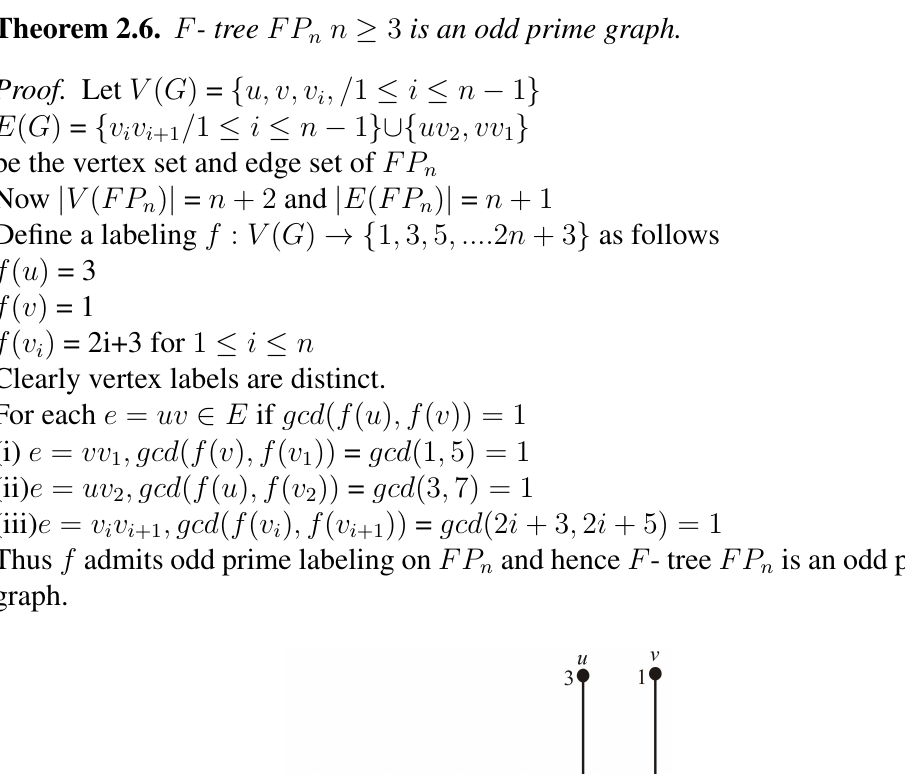
Figure 5: G and its odd prime labeling